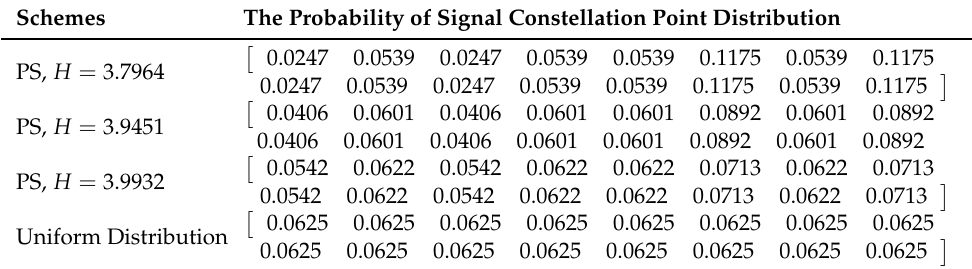
Figure 3. Signal constellation point distribution. ( a ) PS at SNR = 2 dB, H = 3.7964. ( b ) PS at SNR = 10 dB, H = 3.9451. ( c ) PS at SNR = 18 dB, H = 3.9932. ( d ) Uniform distribution. Table 2. Probability of signal constellation point distribution with or without the